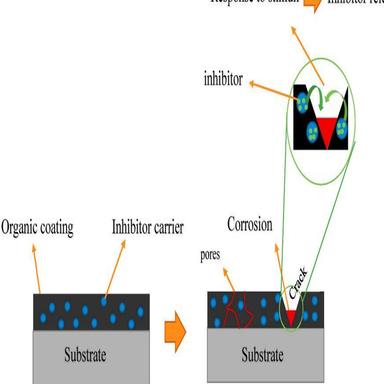
The typical concept of long corrosion protection via employing inhibitor carriers.